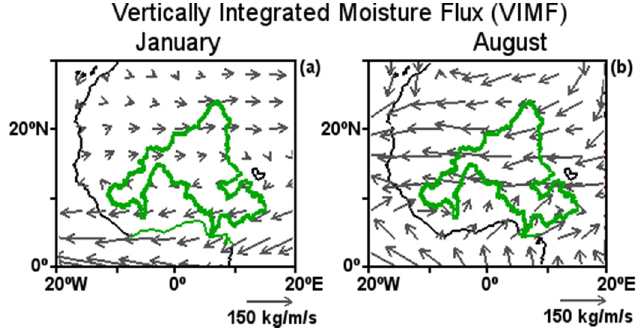
Figure 8. Vertically integrated moisture flux (VIMF) climatology for January ( a ) and August ( b ). Data from ERA-Interim Reanalysis for 1980–2014.